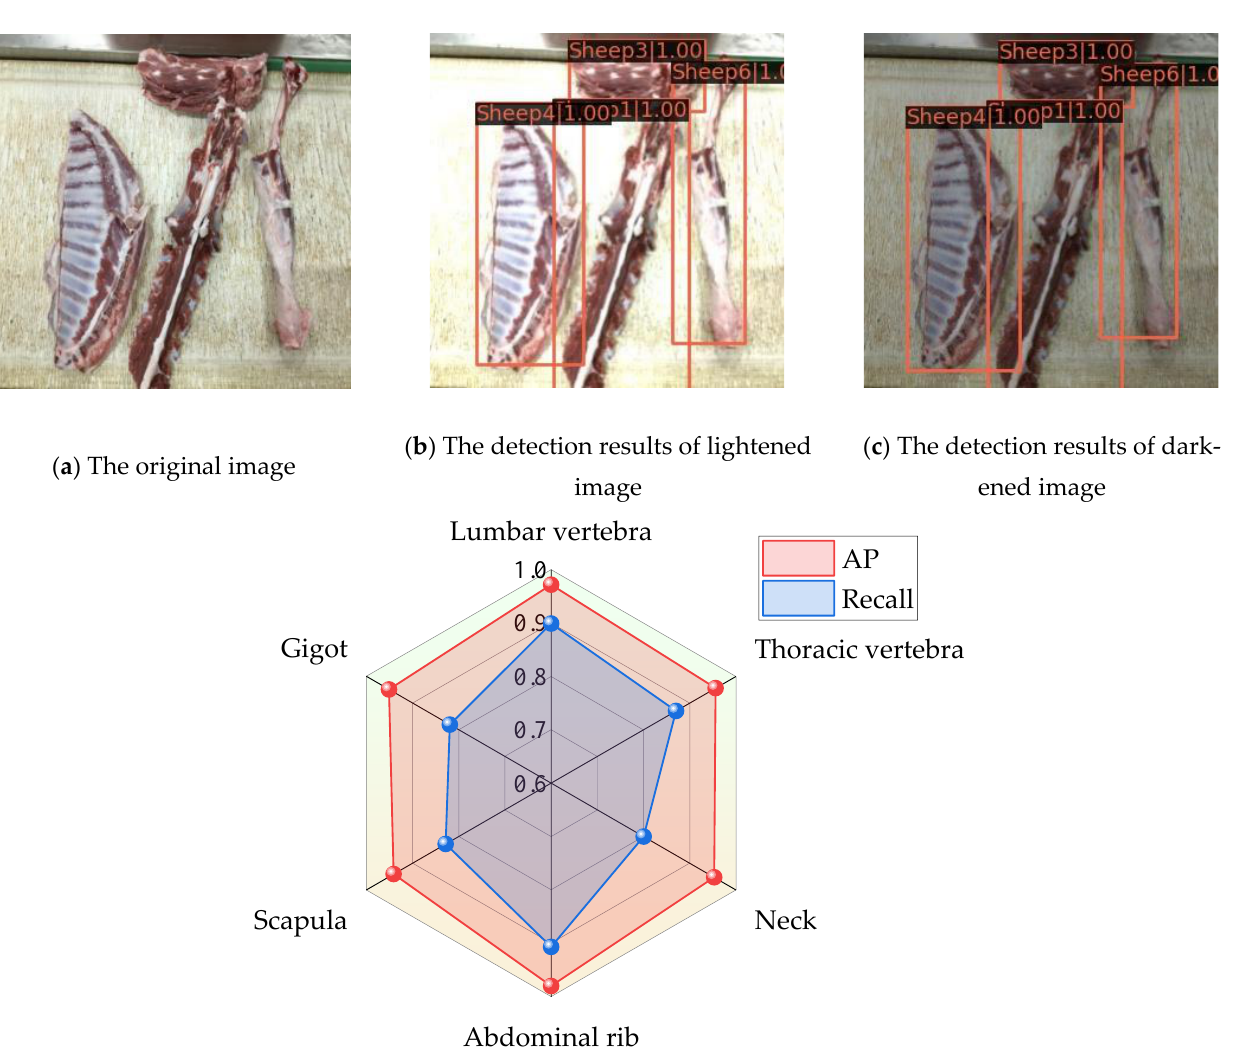
Figure 13. Partial results of the generalization ability test of mutton multi-parts classification and detection.